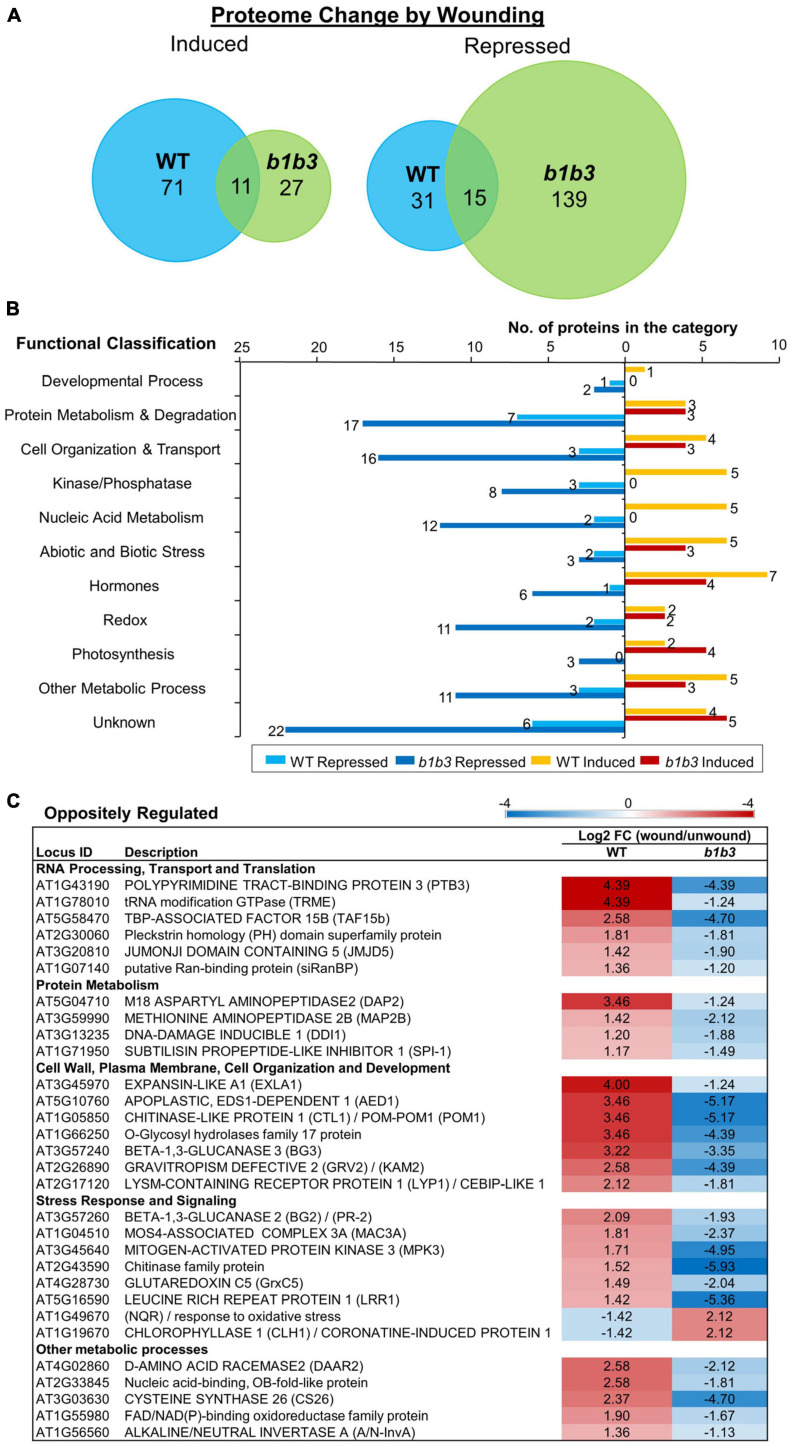
Protein changes by wounding in WT and b1b3 leaves. (A) Area-proportional Venn diagrams showing number of proteins induced or repressed twofold or more by wounding compared to unwounded leaves of WT and b1b3.
(B) Functional classification of proteins differentially regulated by wounding [fold change (FC) ≥ 2]. GO assignment was based on TAIR. (C) List of oppositely regulated proteins in WT and b1b3 grouped into functional categories. The values are −1 ≥ log2 FC (wound/unwound) ≥ 1 and displayed as a heatmap. Average spectral counts from LC-MS/MS analysis of two biological replicates were used to calculate the FC.